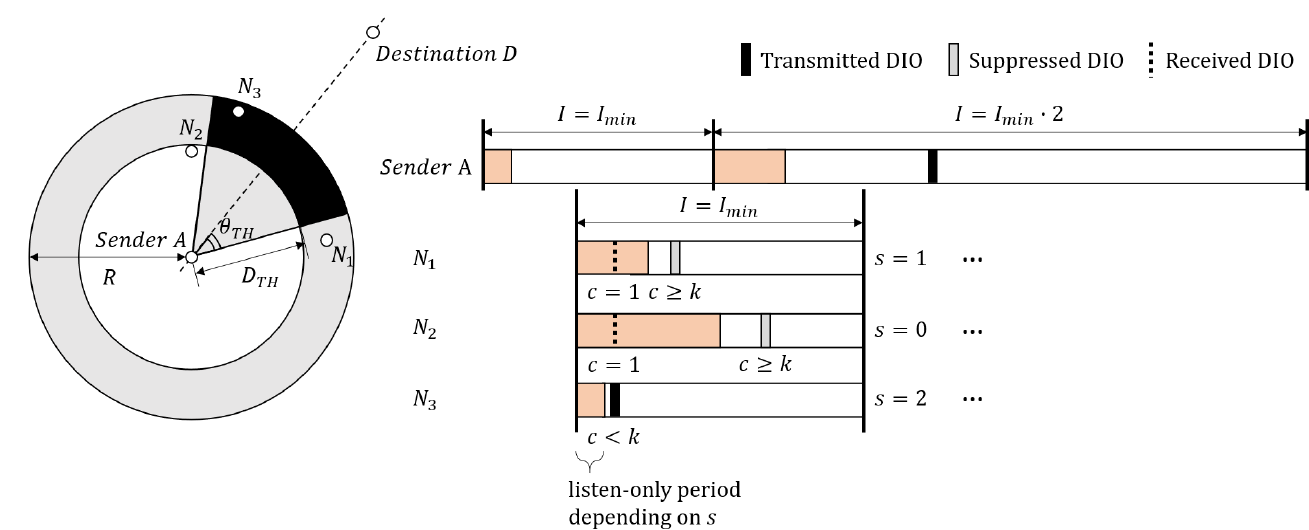
Figure 4. Example of a Collision Avoidance Elastic Trickle operation, k = 1.